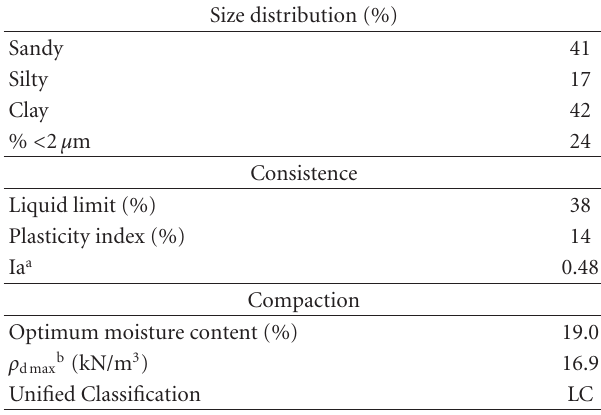
Table 2: Size distribution, consistence, and soil unified classifica-